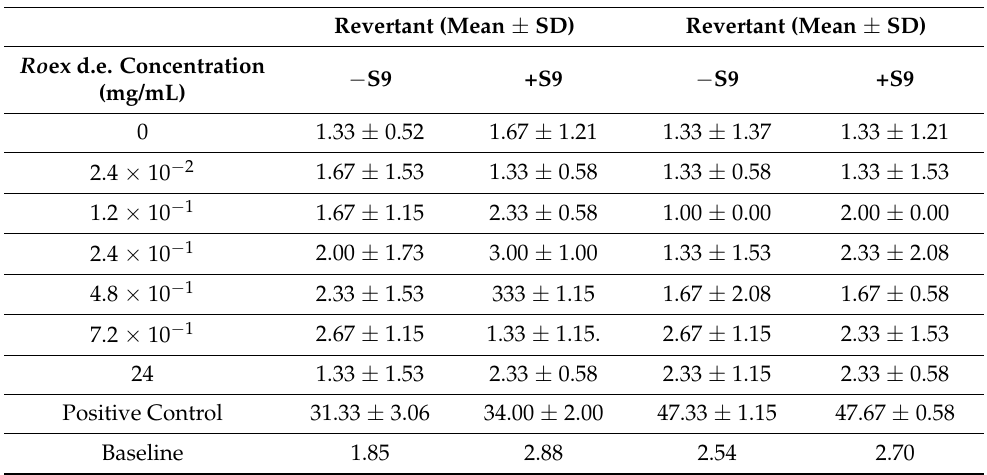
Table 4. Mean number of revertants in S. typhimurium strains 98 and 100, exposed to different concentrations of Ro ex with and without S9 fraction. The results are reported as the mean of revertants ± SD.